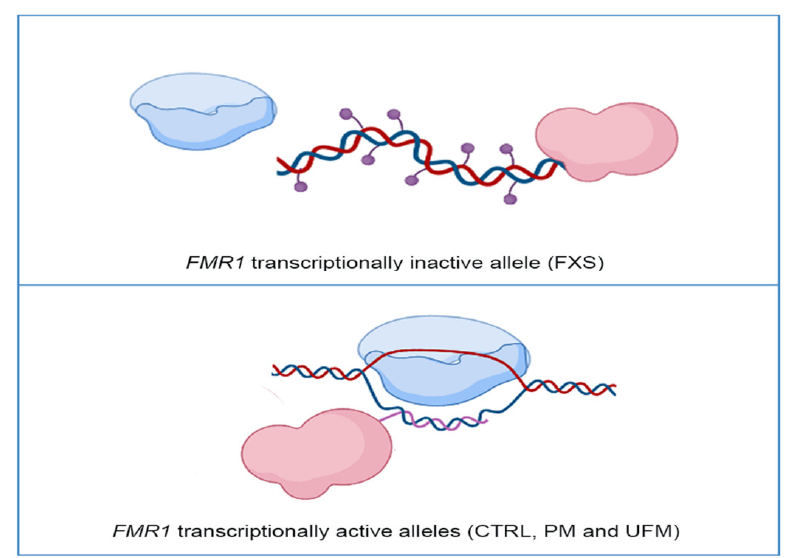
Figure 1. Representative model of DNA methyltransferase 1 (DNMT1) interaction with the FMR1 locus: In FMR1 transcriptionally inactive allele, as in Fragile X syndrome (FXS) individuals, DNMT1 (in pink) freely binds DNA and methylates it (violet dots), preventing transcription through RNA polymerase (in blue) (top panel). In FMR1 transcriptionally active alleles, namely CTRL, PM and UFM, RNA polymerase transcribes RNA (pink line) and DNMT1 binds to nascent RNA and R-loop structures, preventing DNA methylation (bottom panel). Created with BioRender.com.